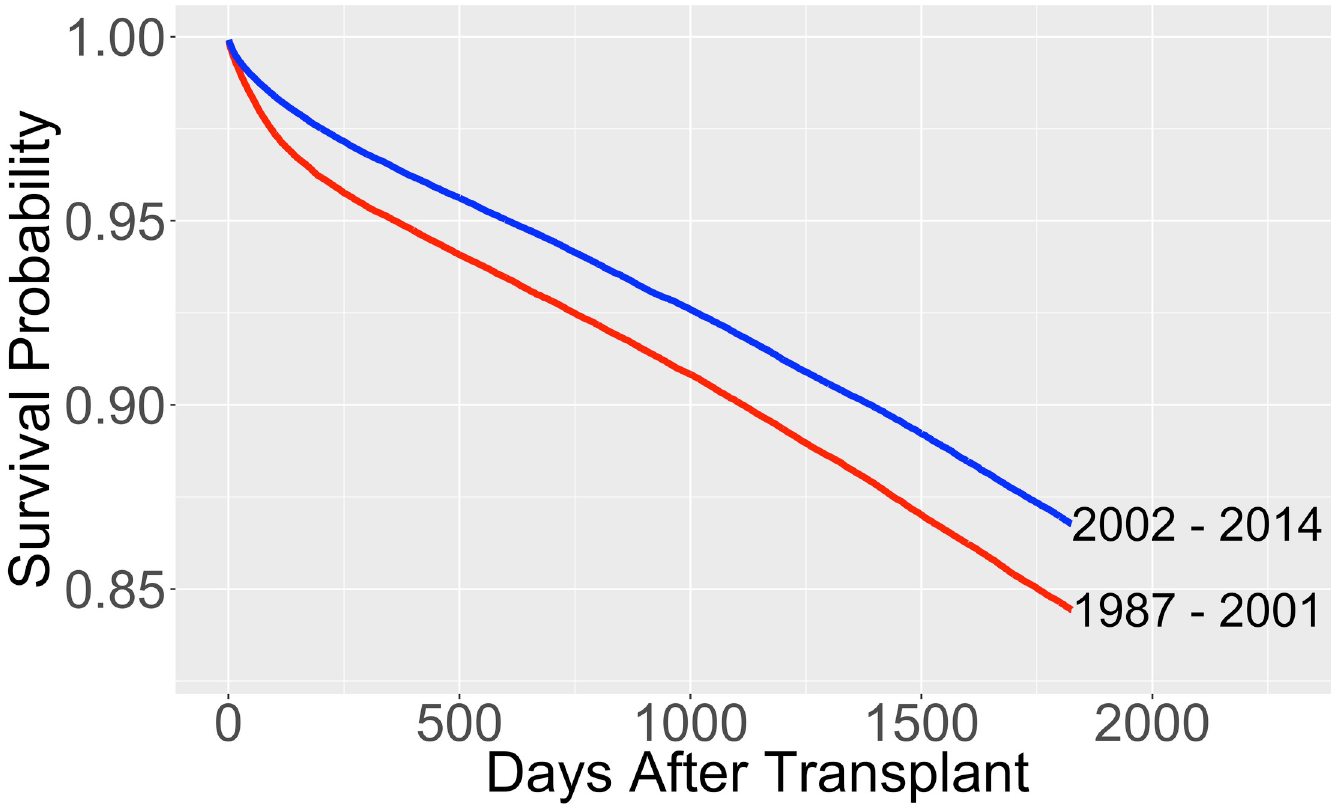
Fig 1. Survival probabilities of different transplant cohorts. The survival probabilities are calculated from the Kaplan-Meier estimate.